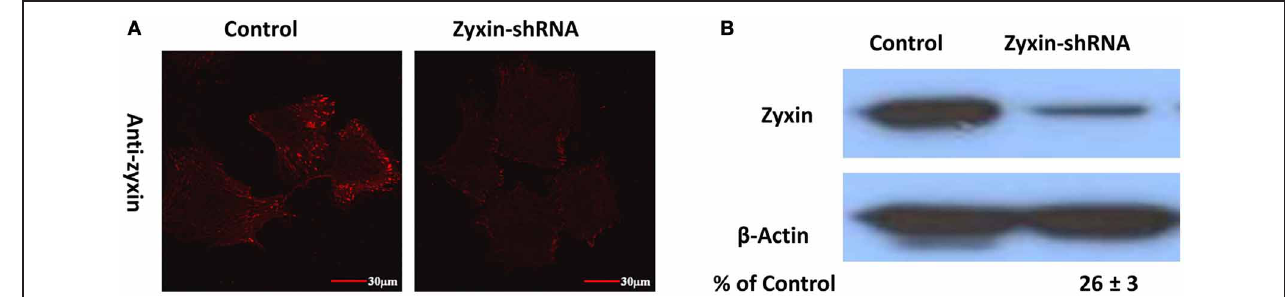
FIGURE 3 | Immunofluorescence (A) and Western blots (B) probed with anti-zyxin antibody showed that zyxin expression was reduced in VSMC stably expressing zyxin-shRNA construct in comparison with cells expressing non-silencing control. Images were taken with a 60x oil